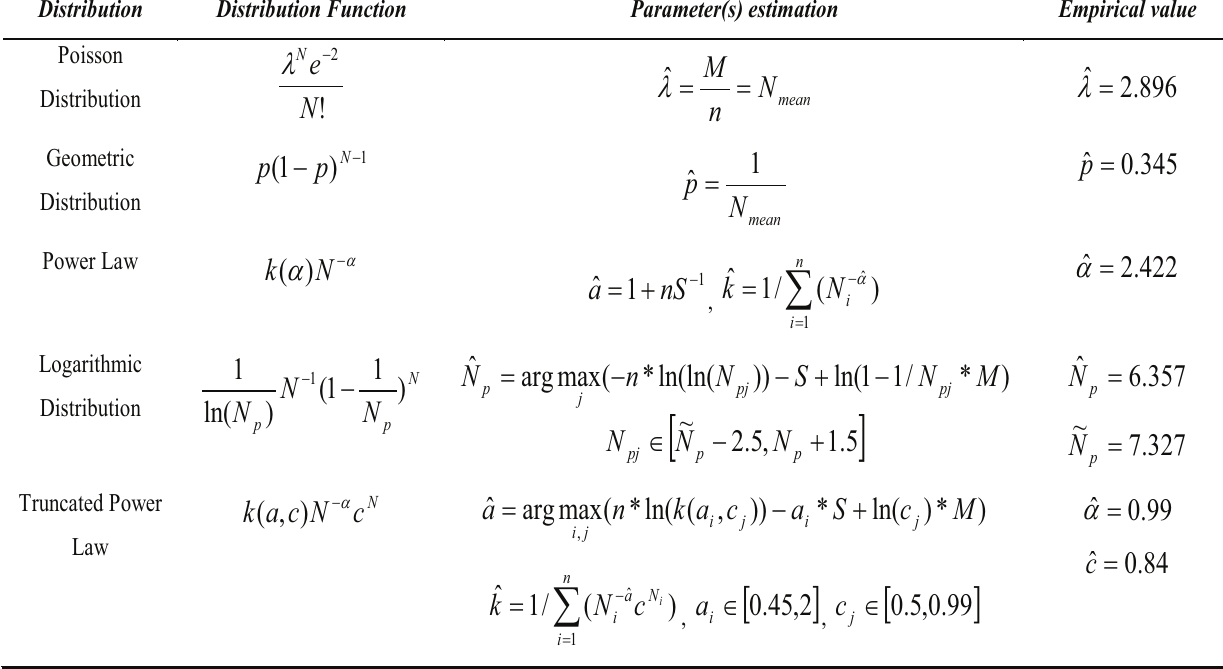
n n N i and S ~ P ln N i ð Þ . For the i ~ 1 i ~ 1